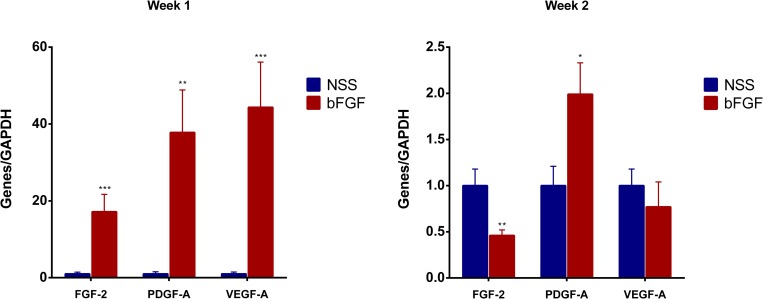
The comparison of the angiogenesis-related genes expression at Weeks 1 and 2 after implantation.The relative expressions of FGF-2, PDGF-A and VEGF-A were strongly up-regulated in the bFGF group at Week 1 (** p < 0.01, *** p < 0.001). The expression of FGF-2 was lower in the bFGF group than in the NSS group (** p < 0.01), while that of PDGF-A was higher in the bFGF group than in the NSS group (* p < 0.05).